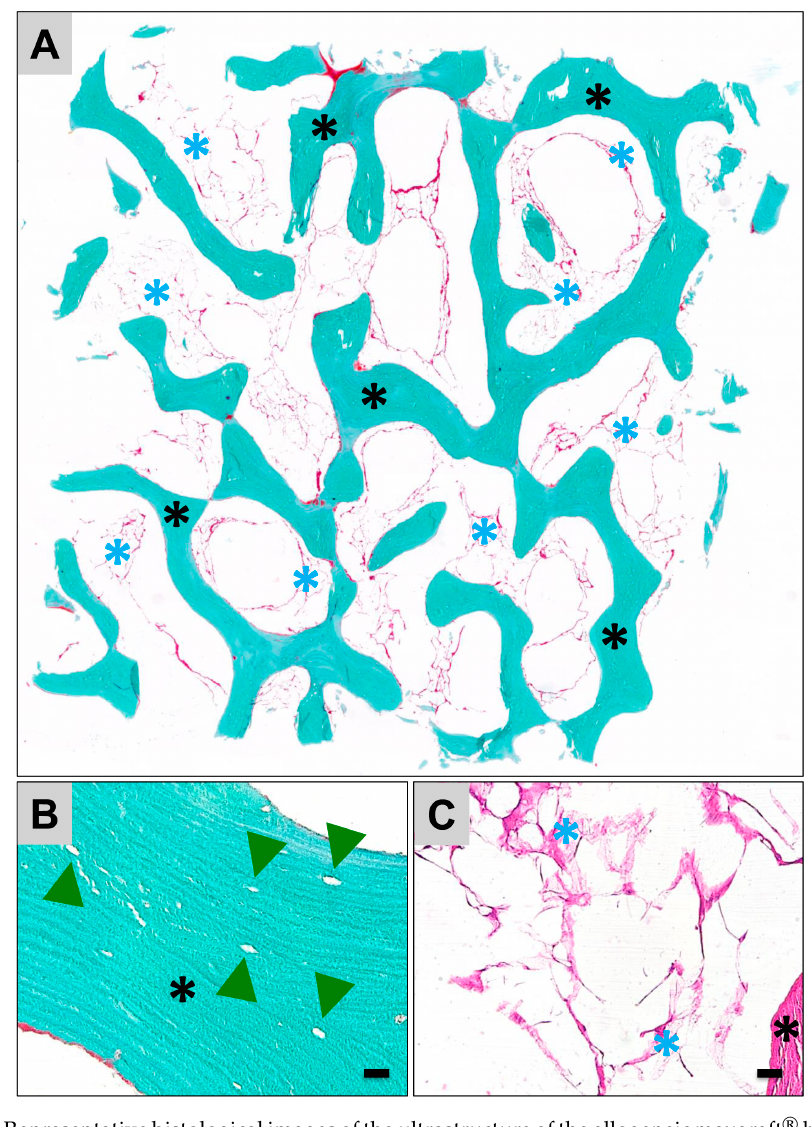
Figure 2. Representative histological images of the ultrastructure of the allogeneic maxgraft ® bone block. ( A ) Overview of the bone block that shows its trabecular structure (black asterisks = trabeculae). Within the trabecular interspaces, high amounts of collagen were overserved (blue asterisks) (Masson–Goldner staining, “total scan”, 10 × magnification). ( B ) maxgraft ® shows a lamellar bone matrix organization. No signs of cells or cell remnants were detected within the osteocyte lacunae (green arrow heads) nor adherent to the outer surfaces of the bone matrix (Masson–Goldner staining, 40 × magnification, scale bar = 10 µ m). ( C ) Within the trabecular interspaces (black asterisk = trabecula) collagenous structures (blue asterisks) were observable (hematoxylin and eosin (HE)-staining, 40 × magnification, scale bar = 10 µ m).